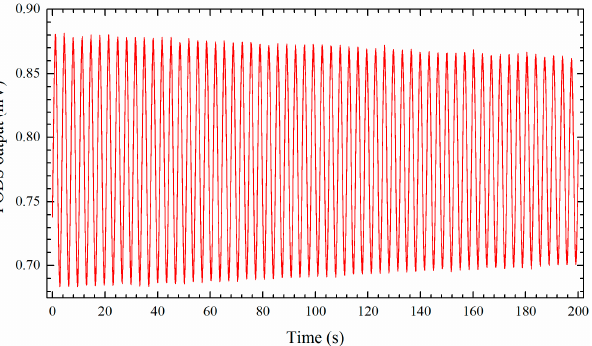
Figure 5. FODS output voltage as a function of time for the torsional balance excited by an impulsive perturbation.